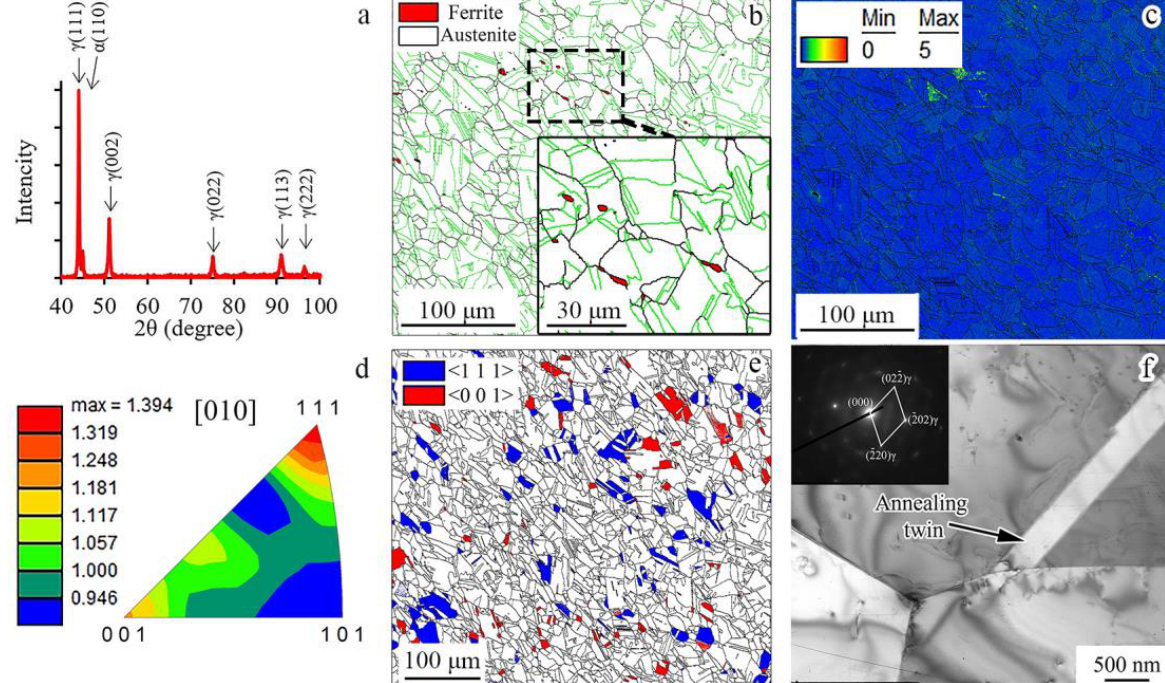
Figure 2. ( a ) XRD pattern, ( b ) phase map, ( c ) KAM map, ( d ) inverse pole figure, ( e ) crystal direction map, and ( f ) TEM photograph of the as-received material. In ( b ), ( c ), and ( e ), the high-angles boundaries (misorientation more than 15°) are marked in black. Twin boundaries are marked in green in ( b ).